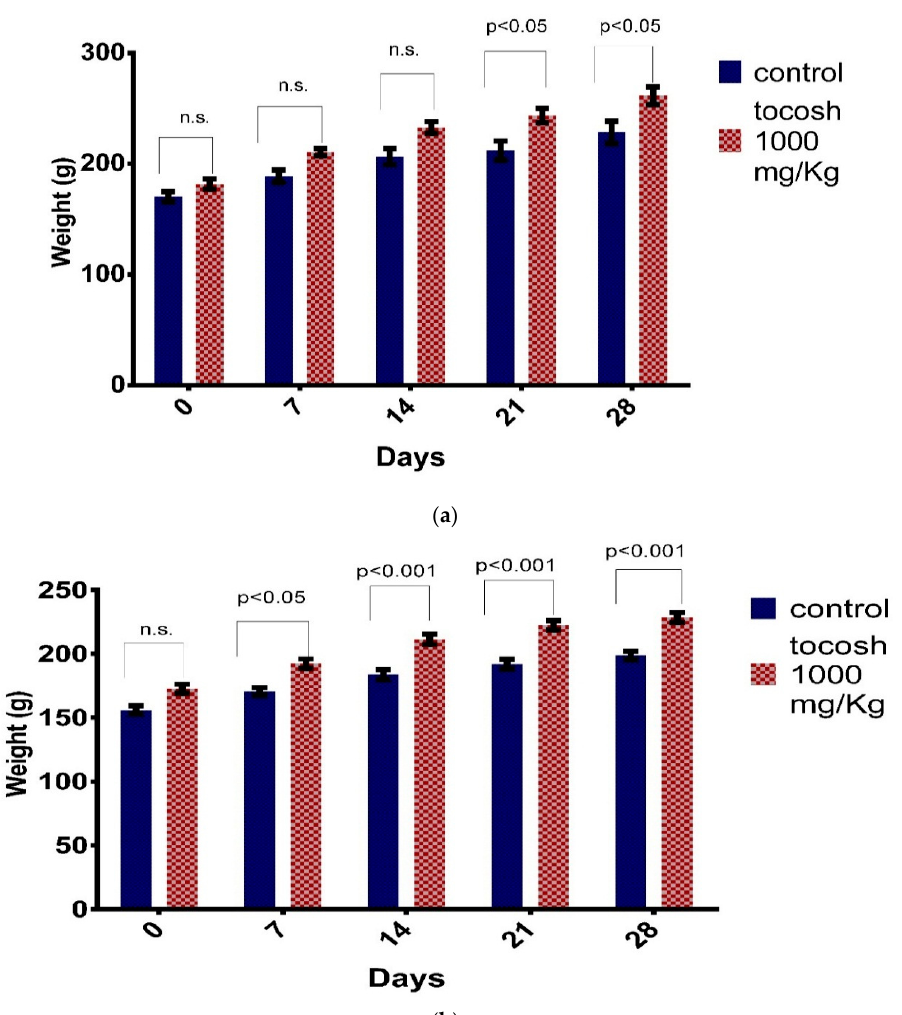
Figure 3. Body weights of rats treated with repeated oral doses of tocosh flour (1000 mg/kg) for 28 days. ( a ) male rats and ( b ) female rats. * p < 0.05, ** p < 0.001 compared to control, by using the Student t -test.